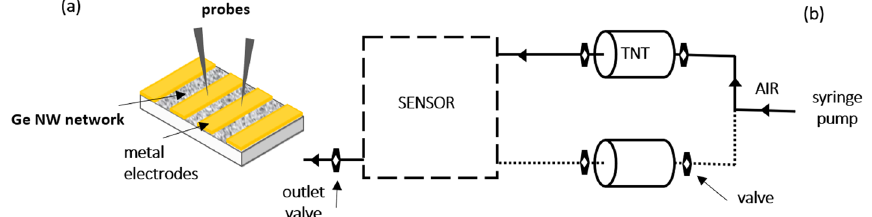
Fig. 1 a Schematic of a Ge NW network deposited on sapphire substrate showing metal electrodes contacting the network; Au contact areas = 5 mm 2 , contact spacing = 1 mm. b Diagram of experimental setup used in sensing